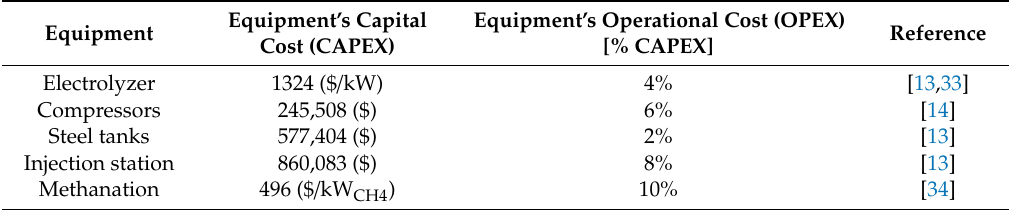
Table 2. Capital expenses (CAPEX) and operating costs (OPEX) of main Power-to-Gas (PtG) pathways components.